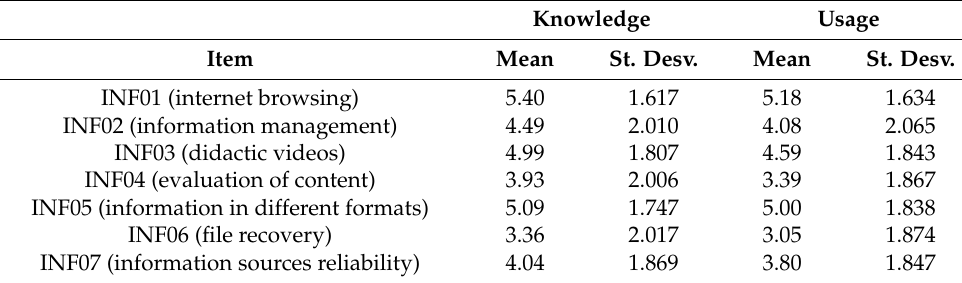
Table 6. Information access and management tools (INF).